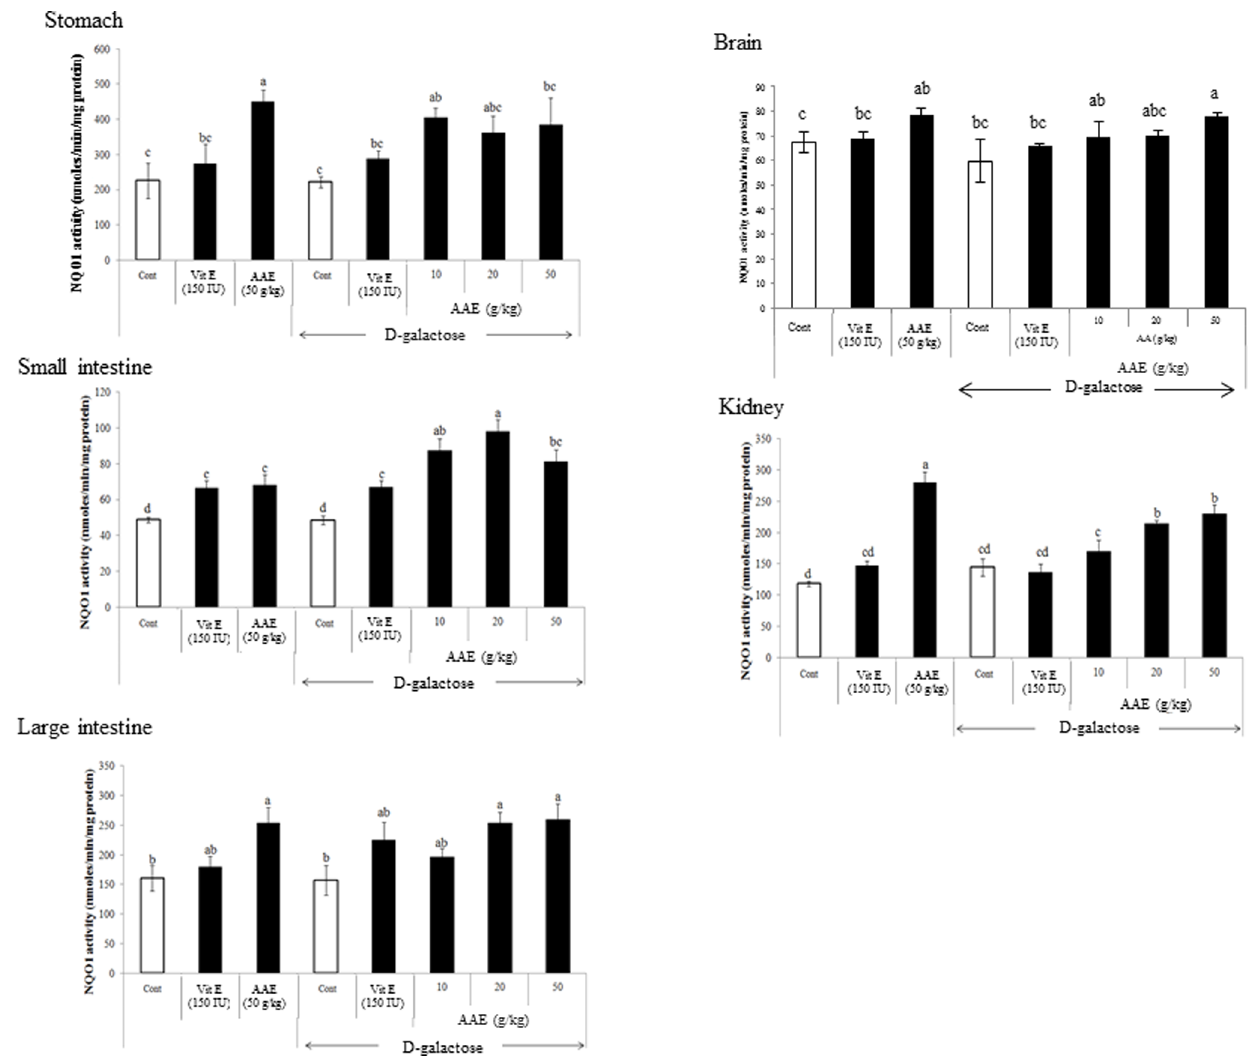
Figure 4. Effect of AA extract diet on NQO1 activity in mouse tissues. C57BL/6J mice (5-week old, n=10) were treated with AA extract with and without D-galactose exposure for 6 weeks, and then subjected to assay for NQO1 enzyme activity in stomach, small intestine, large intestine, kidney, and brain. Values are means 6 SE (n=10). Means without a common letter differ, P , 0.05.